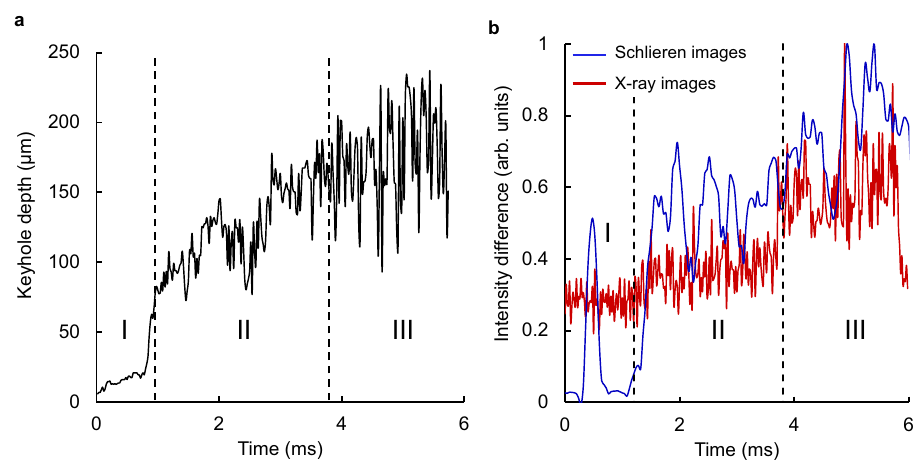
Fig. 3 Analysis of vapour depression evolution. a Measured surface depression depth. The keyhole depth increases gradually during stage I, with a rapid drilling marking the transition to stage II. The penetration fl uctuates increasingly over time, due to keyhole instabilities. b For both datasets, the total change in each frame increases over time as the system tends towards instability. Stages I – III of keyhole evolution are discernible in both datasets, owing to the strong coupling of liquid-vapour